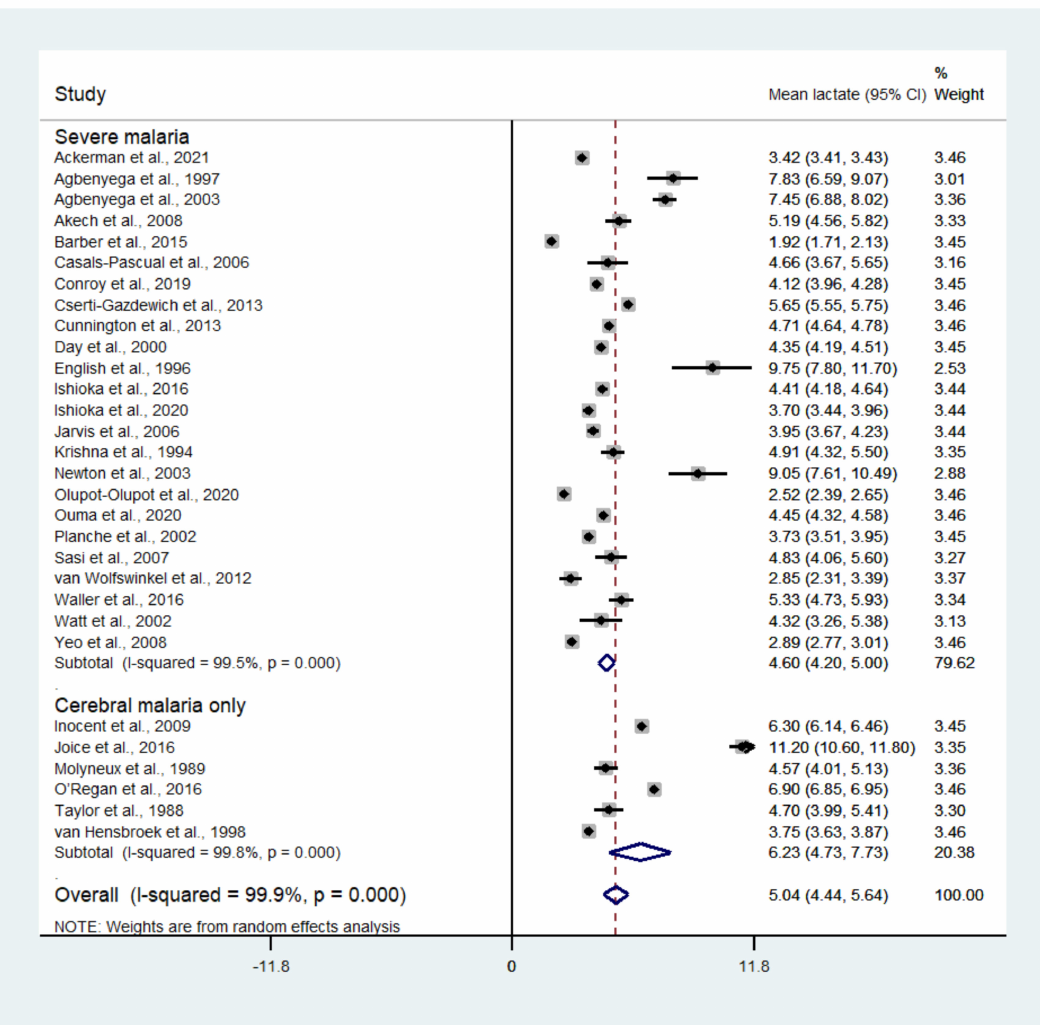
Figure 2. Mean lactate level in patients with severe malaria. Abbreviation, CI: confidence